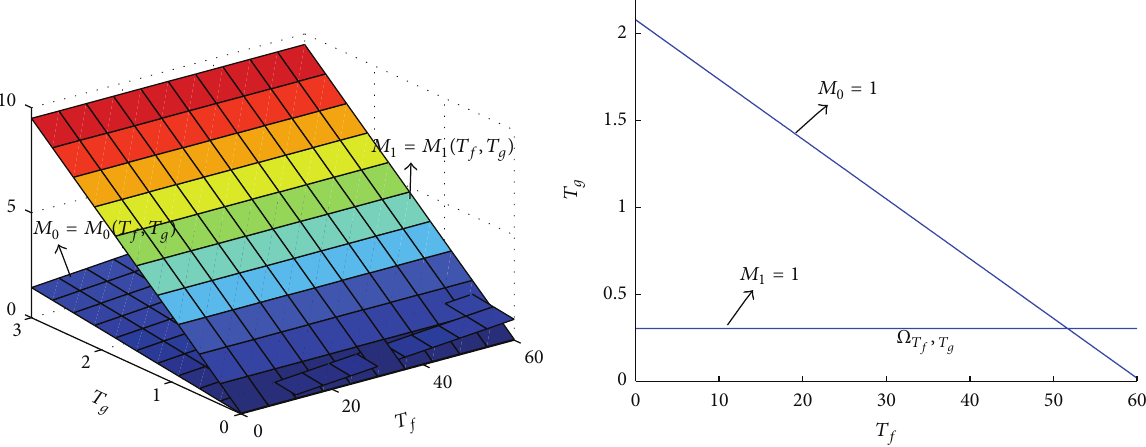
Figure 7: The positive equilibrium 𝐸 ∗ is stochastically stable provided that (𝑇 𝑓 ,𝑇 𝑔 ) ∈ Ω 𝑇